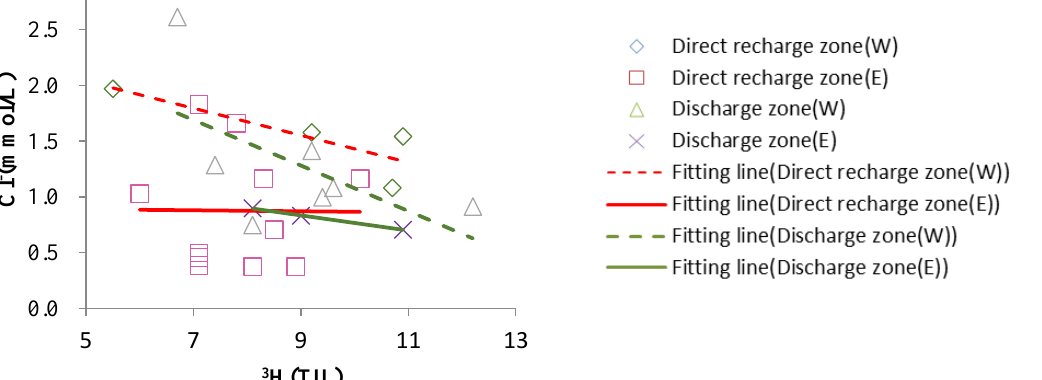
Figure 11. Correlation between the concentration of Cl − and 3 H concentration in karst water.